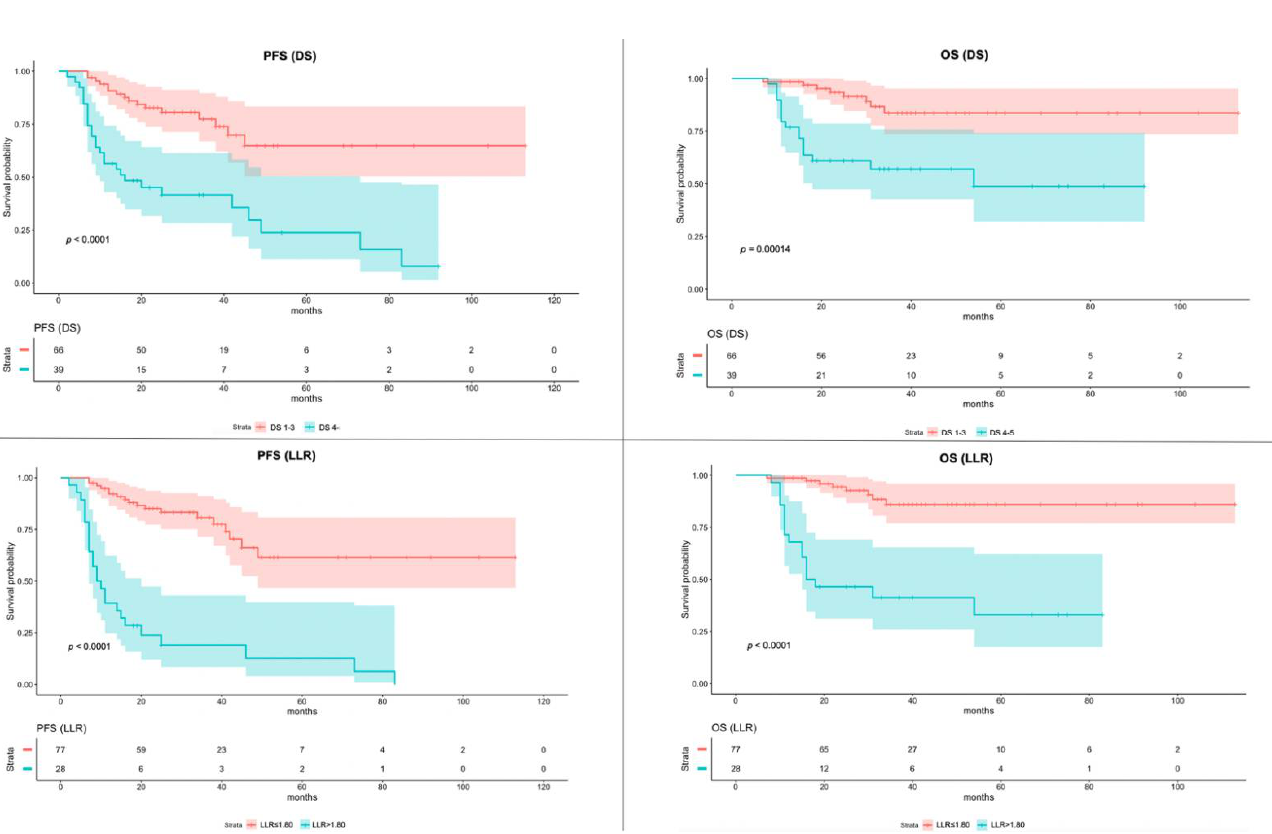
Figure 2. Kaplan–Meier of Progression-Free Survival (PFS) and Overall Survival (OS) according to the Deauville Score (DS) and Lesion-to-Liver SUVmax ratio (LLR). The color bands around the median values of PFS and OS represent the 95% confidence interval.